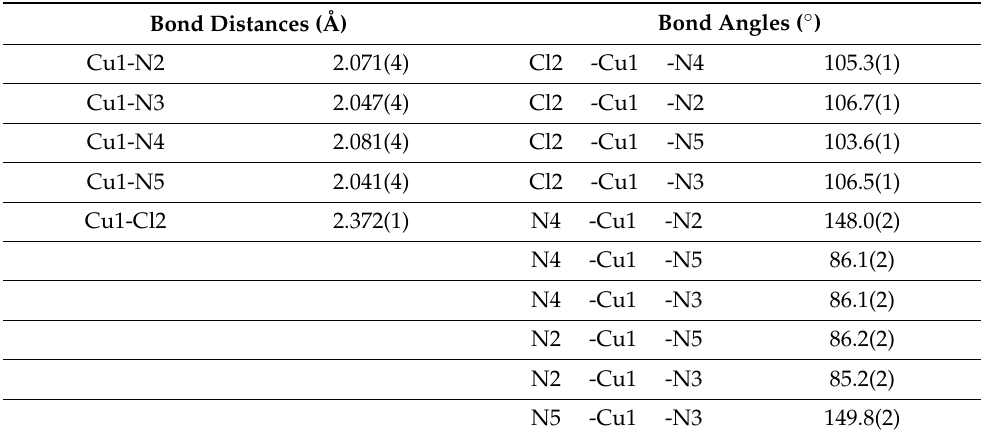
Figure 4. Views of the [Cu(L)Cl]ClO 4 · CH 3 CN crystal structure. Top: asymmetric unit content and Cu(II) coordination environment. Bottom: head to tail dipolar interactions linking adjacent complexes through Cu-coordinated Cl − and sulfonamide H-bond donors. Table 1. Bond distances and angles defining the Cu(II) coordination environment in the crystal structure of [Cu(L)Cl]ClO 4 · CH 3 CN.